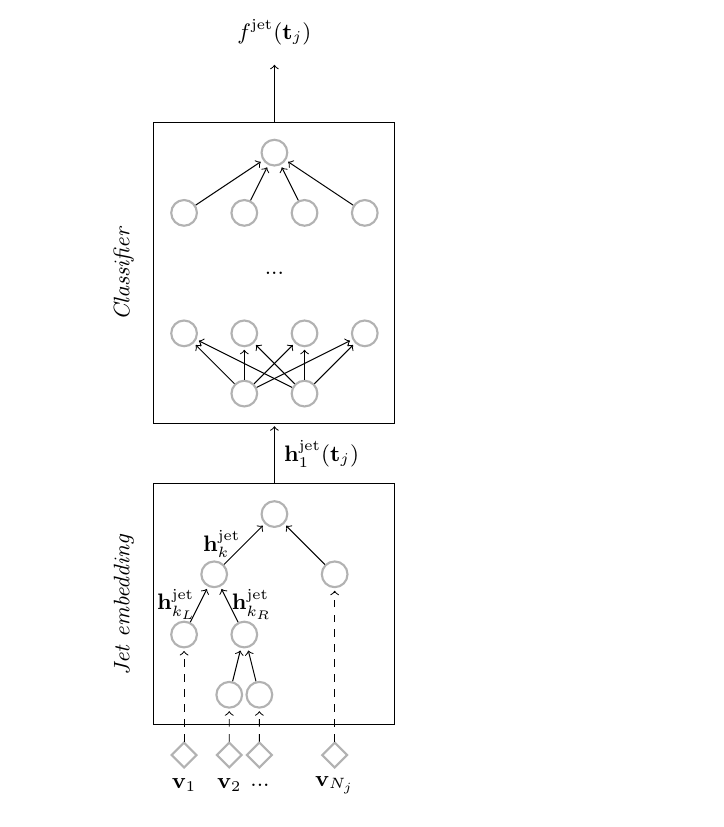
Figure 1 . QCD-motivated recursive jet embedding for classi(cid:12)cation. For each individual jet, the embedding h jet ( t j ) is computed recursively from the root node down to the outer nodes of the 1 binary tree t j . The resulting embedding is chained to a subsequent classi(cid:12)er, as illustrated in the top part of the (cid:12)gure. The topology of the network in the bottom part is distinct for each jet and is determined by a sequential recombination jet algorithm (e.g., k t